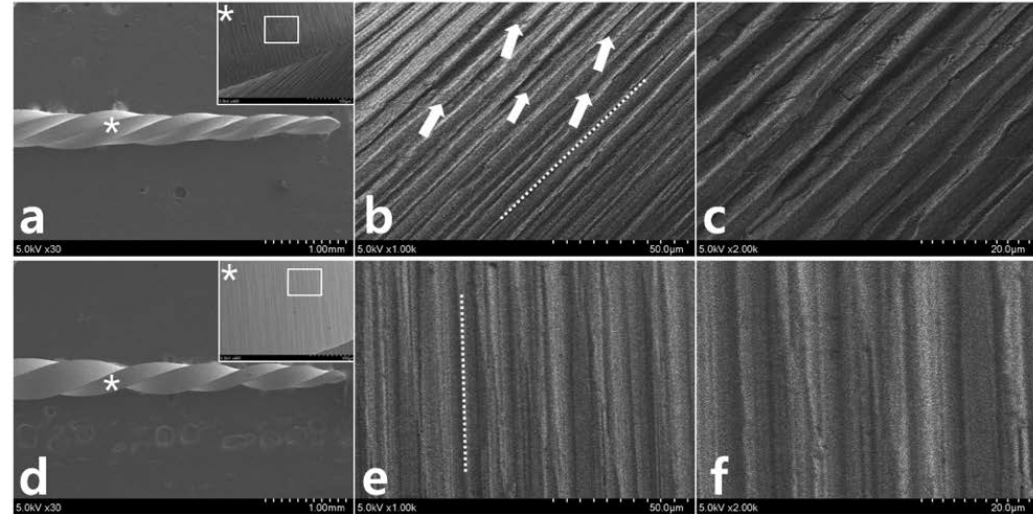
Figure 4. Scanning electron microscopy observation after 150-degree repetitive loading for ( a ) WO and ( d ) WOG (* indicates the restricted area of 3 mm level). ( b ) WO and ( e ) WOG show machining grooves (dotted lines) without distortion (magnified views ( b , e ) are from the box in the ( a , d ), respectively). WO shows evidence of longitudinal micro-cracks ( white arrows in ( b )). ( c , f ) are the magnified aspects from ( b , e ), respectively.